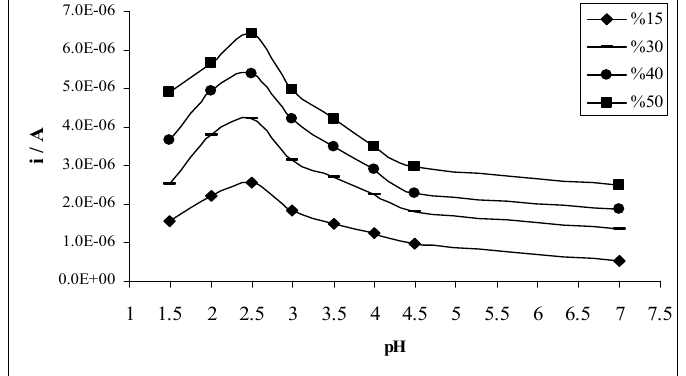
Figure 4. Effects of acetonitrile-water ratio and pH on the MIP modified PGE response for 0.10 mM sulfamethoxazole in Britton-Robinson buffer